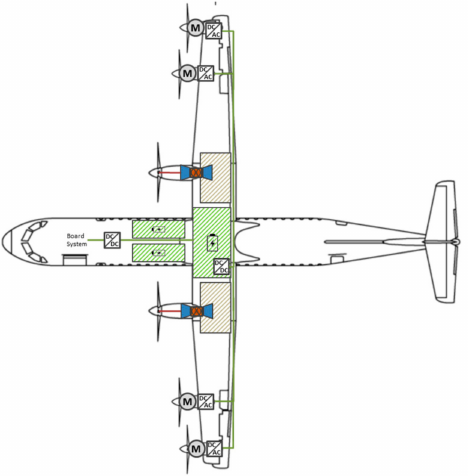
Figure 1. Schematic wingtip propeller architecture for an